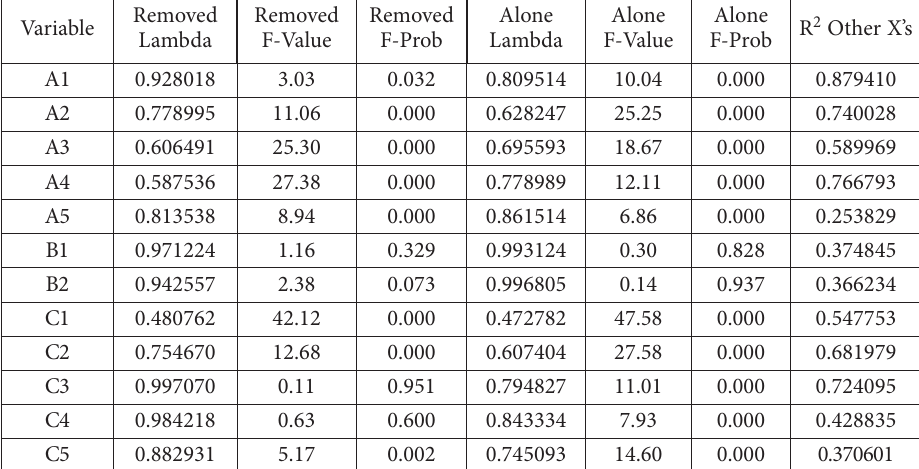
Table 5. Variable influence analysis (source: authors’ computation)